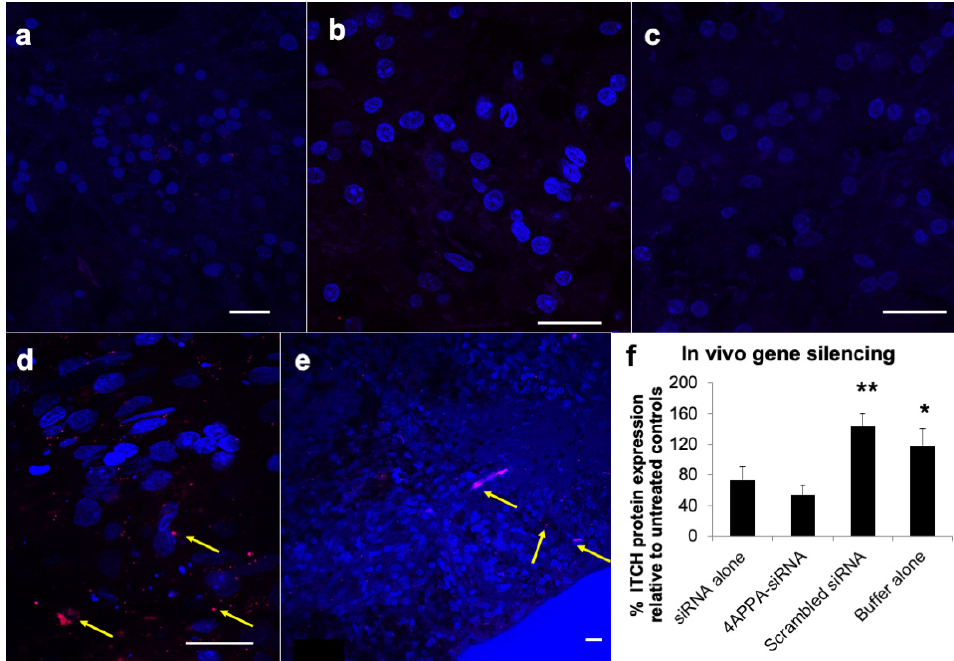
Figure 4. CLSM images ( a – e ) with the nucleus stained blue with DAPI and Cy 3 -siRNA-GAPDH stained red–arrowed and in vivo gene silencing ( f ) in rat brain tissue. Bar = 20 µ m; All formulations were dosed in phosphate buffer (2mM, pH = 6.0): ( a ) rat olfactory bulb 5 min after the intranasal